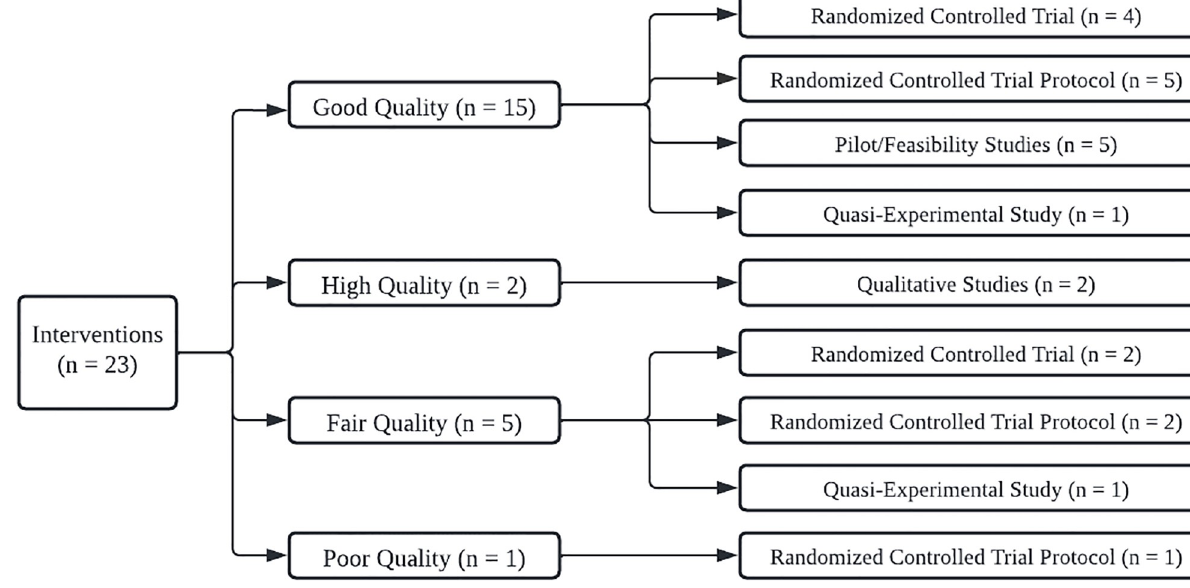
Fig 2. Characteristics and types of interventions